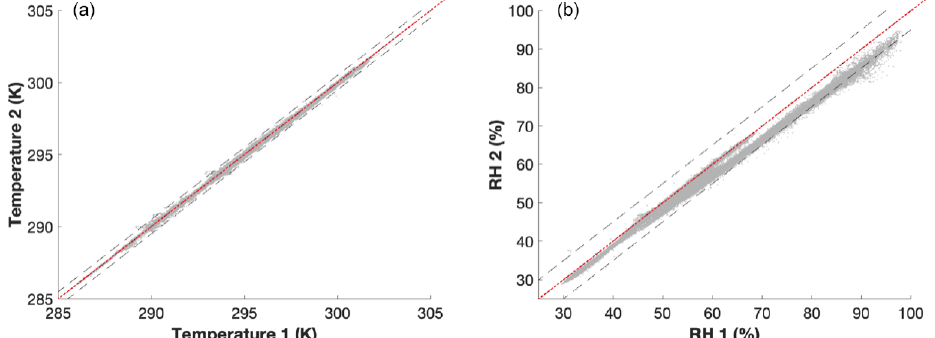
Figure 8. A comparison of temperature (a) and relative humidity (b) observations from the two Vaisala RSS-421 sensors on RAAVEN for all flights. The red dotted lines represent a one-to-one agreement, with the dashed black lines representing 0.5 ◦ (for temperature) and 5% (for relative humidity) deviation from perfect